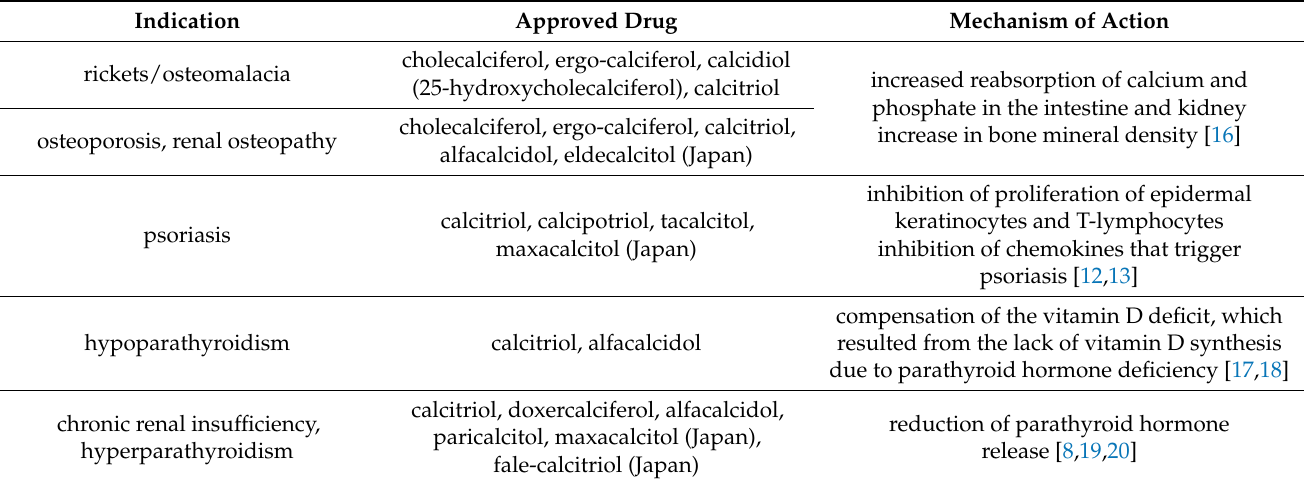
Table 1. Summary of the various vitamin D analogues approved as drugs, their indication in relation to different illnesses, and the mechanism of action within the